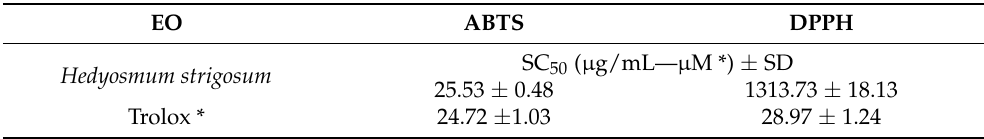
Table 4. Half scavenging capacity of H. strigosum, EO.